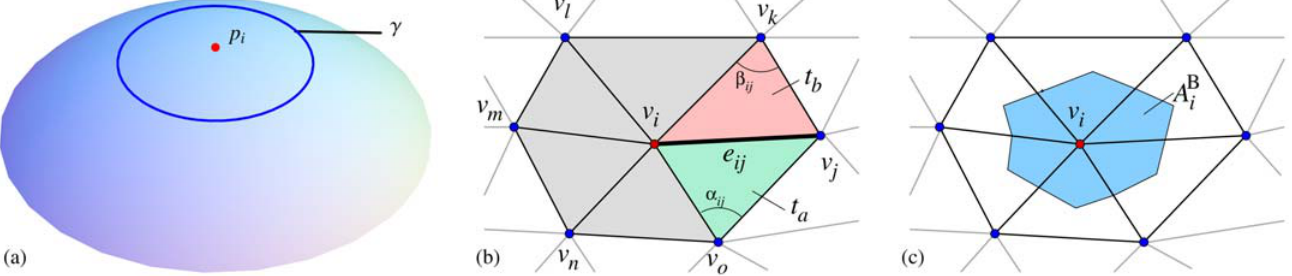
Fig 1. The approximation of the Laplace-Beltrami operator using Eq (9). (a) continuous representation; (b) discrete representation. The neighborhood i ?